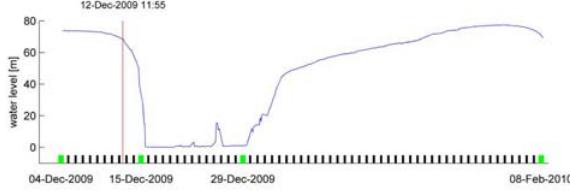
Figure 6: Water level at Lago Nef Norte over a two months period